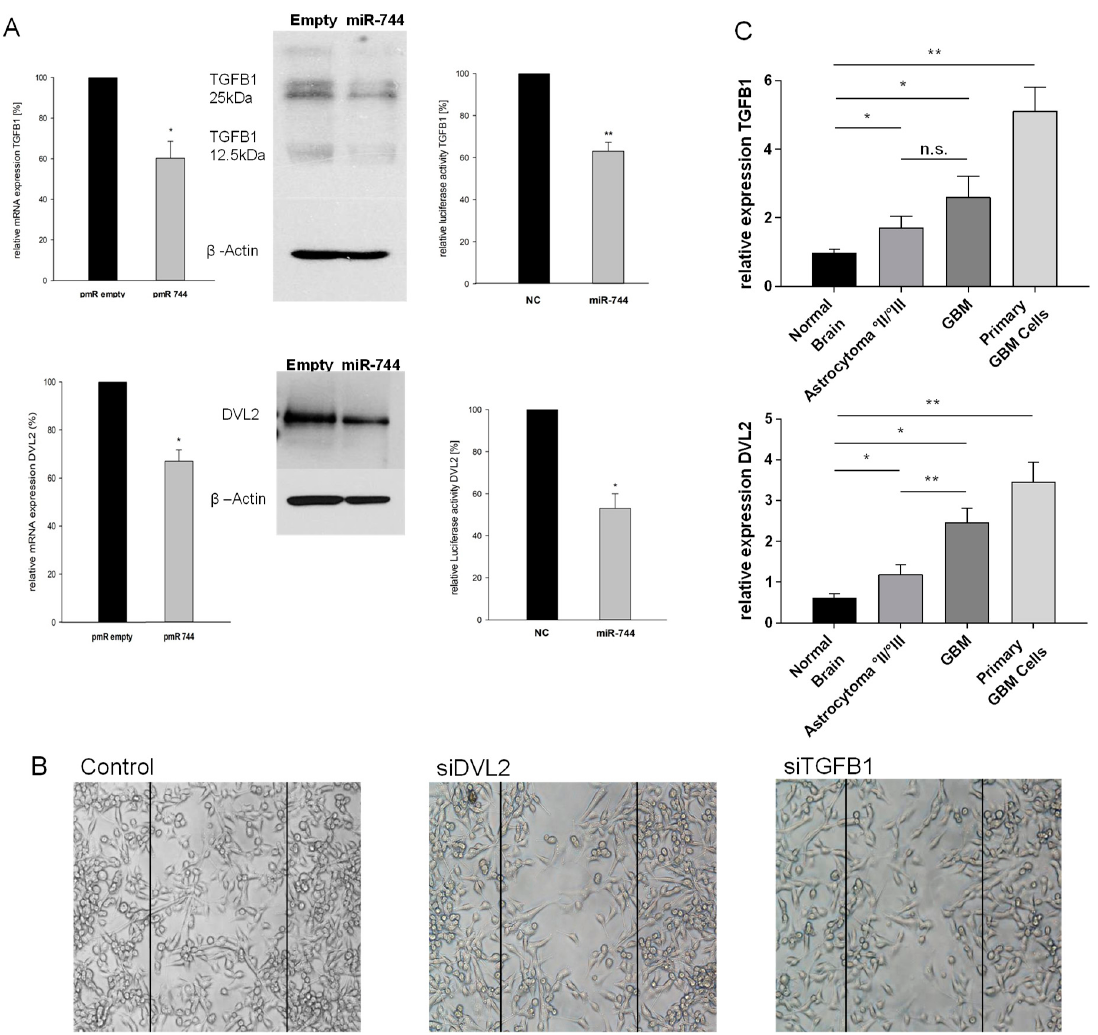
Figure 3. Transforming Growth Factor Beta 1 (TGFB1) and Dishevelled2 (DVL2) are direct targets of miR-744, regulate migration, and are induced in GBM and in Astrocytoma °II/°III. ( A ) Left and middle panels: mRNA and protein expression of TGFB1 and DVL2 in U87 cells stably transfected with miR-744 or empty vector control, respectively (n = 5, p < 0.05). Right panels: TGFB1 and DVL2 3’UTR Luciferase Reporter Gene activity after co-transfection of the respective reporter vectors with miR-744 or with scrambled control, respectively (DVL2: − 47% ± 3,2%, TGFB1: − 37% ± 2%, n = 5, p < 0.05). All Luciferase and mRNA experiments were performed in triplicates. ( B ) 2D migration assay after transient knock-down of DVL2 and TGFB1 in U87 cells. One representative example of 3 experiments is shown. ( C ) Expression of DVL2 and TGFB1 mRNA in Astrocytoma °II/°III biopsies (n = 10, p < 0.05), GBM biopsies (DVL: n = 17, p = 0.001; TGFB1: n = 39, p = 0.015), and primary GBM cell lines (n = 8, p < 0.001), as compared to normal brain tissue (n = 9). ** p < 0.001; * p < 0.05. n.s. = not